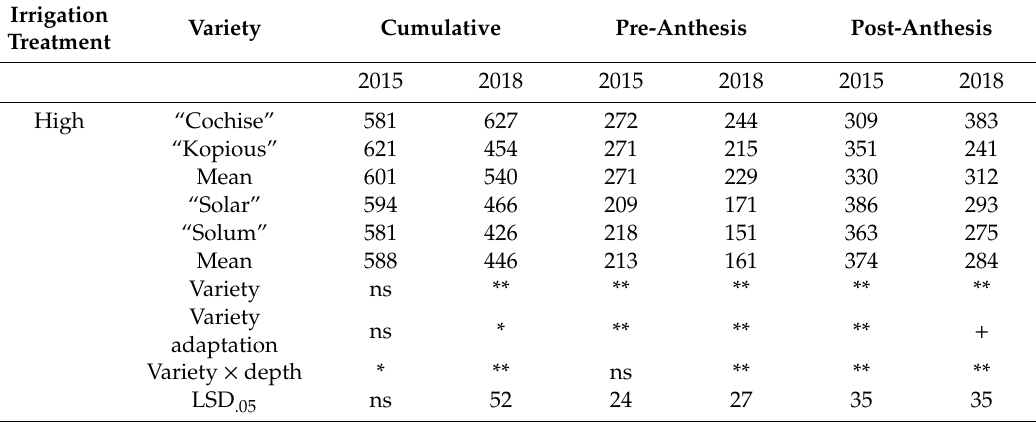
Figure 8. Cumulative water use (mm) since days after planting: ( a ) 2015, high irrigation; ( b ) 2015, low irrigation treatment; ( c ) 2018, high irrigation; ( d ) 2018, low irrigation treatment. Crossmark “×” indicates significant difference at p < 0.05. Table 8. Effect of irrigation treatment on barley water use (mm) for trials conducted in Tucson in 2015 and 2018.